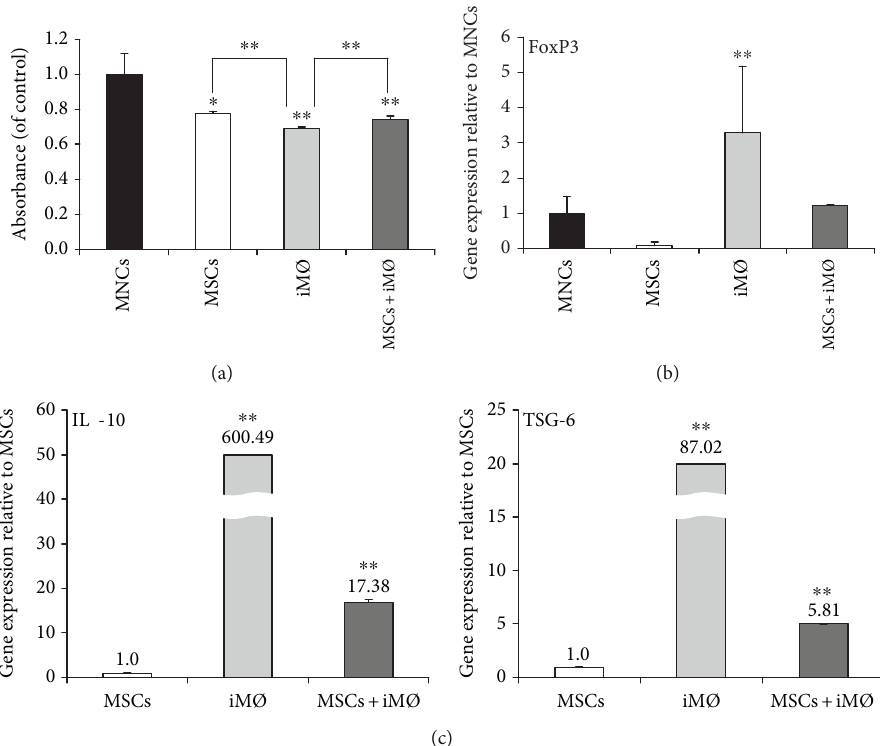
Figure 2: Immunomodulatory e ff ects on activated T cells cocultured with AdMSCs, iM Φ , and AdMSCs+iM Φ . (a) Proliferation of PBMCs cocultured with various cells for 72h was analyzed by a WST-based proliferation assay kit to examine suppression of PBMCs by the di ff erent cells. (b) Relative gene expression of FoxP3 was signi fi cantly increased in iM Φ -alone culture condition. (c) The relative gene expression levels of IL-10 and TSG-6 , immunomodulatory- and anti-in fl ammatory-related factors, were evaluated by qPCR. The data are expressed as the mean ± SD of three independent experiments. ∗ P < 0 : 05 , ∗∗ P < 0 : 01